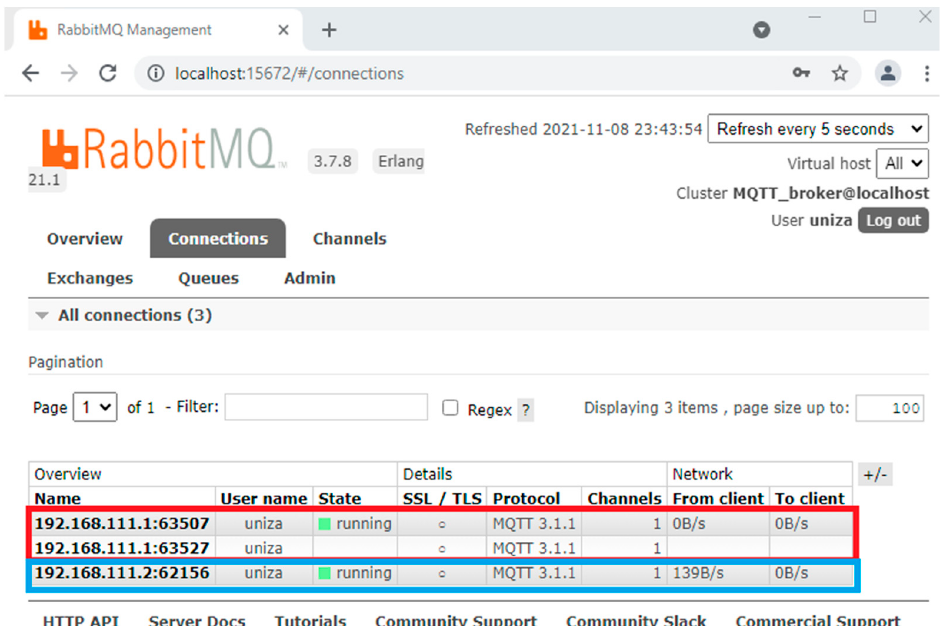
Figure 9. RabbitMQ as MQTT broker with sensor connections.